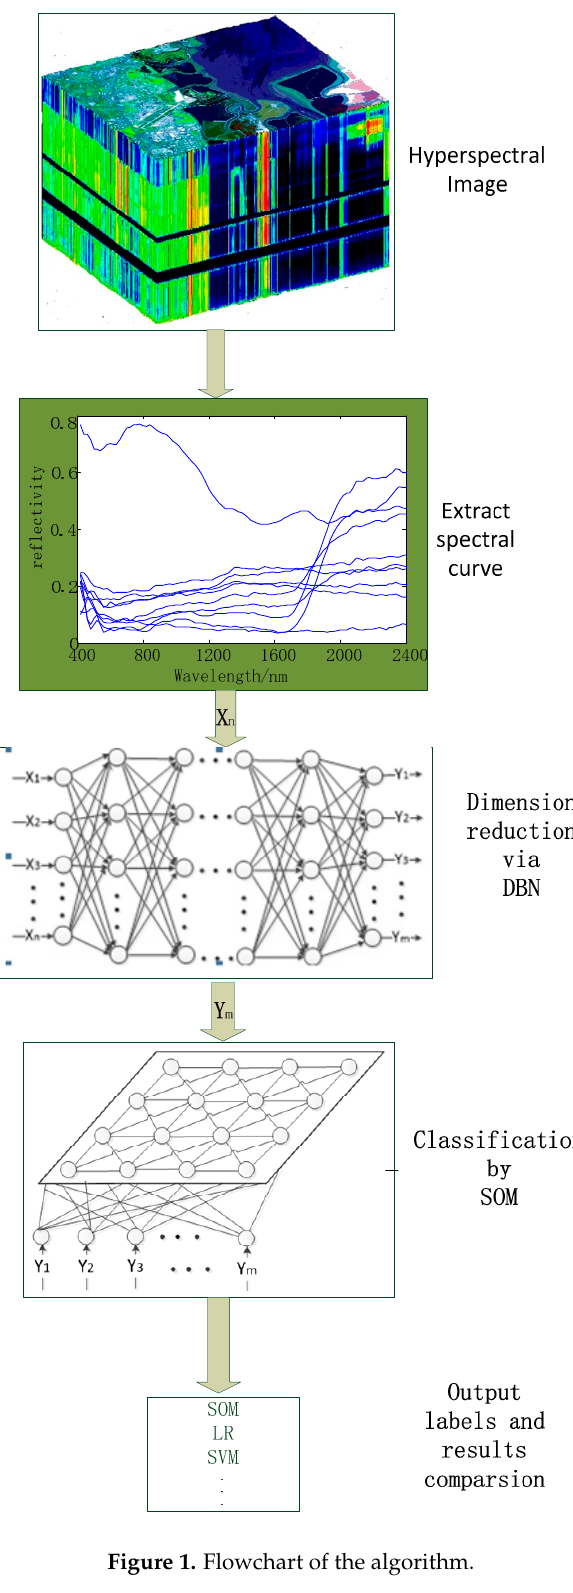
Figure 1. Flowchart of the algorithm.